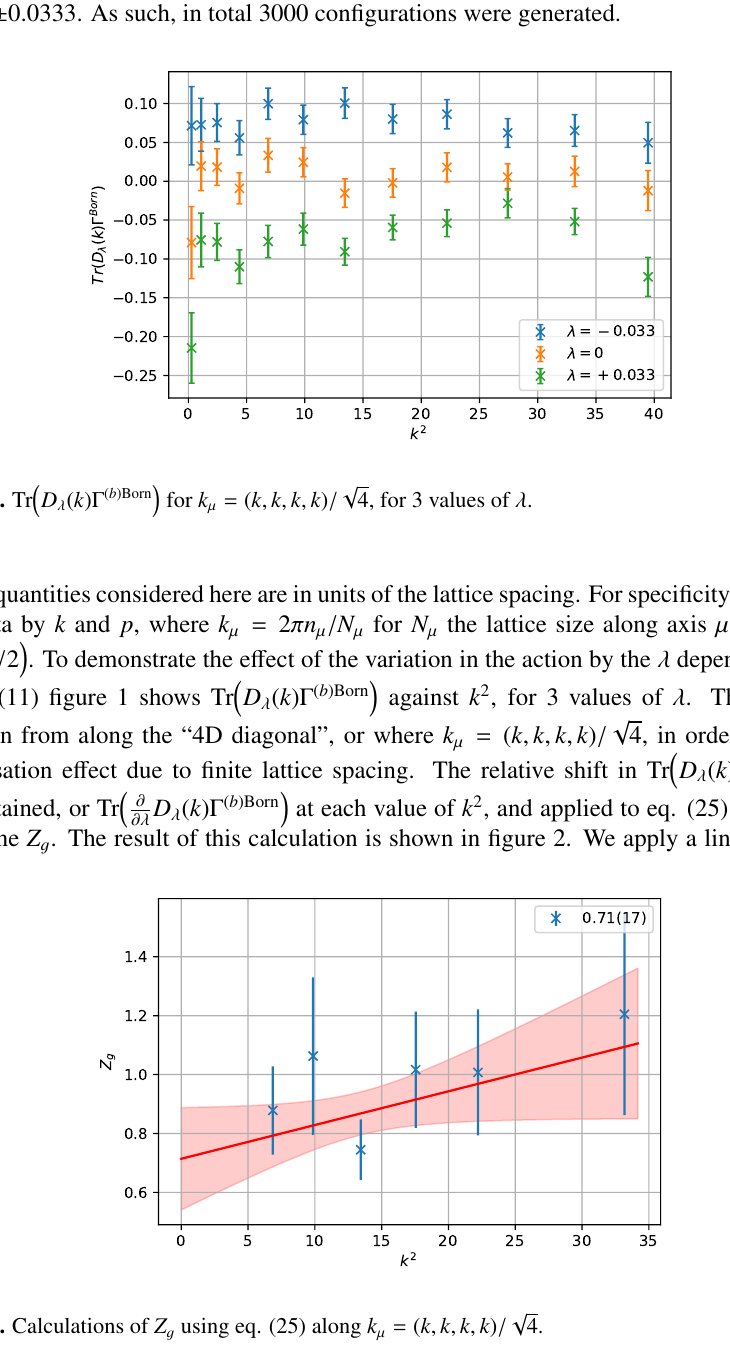
Figure 2. Calculations of Z g using eq. (25) along k µ = ( k , k , k , k ) /